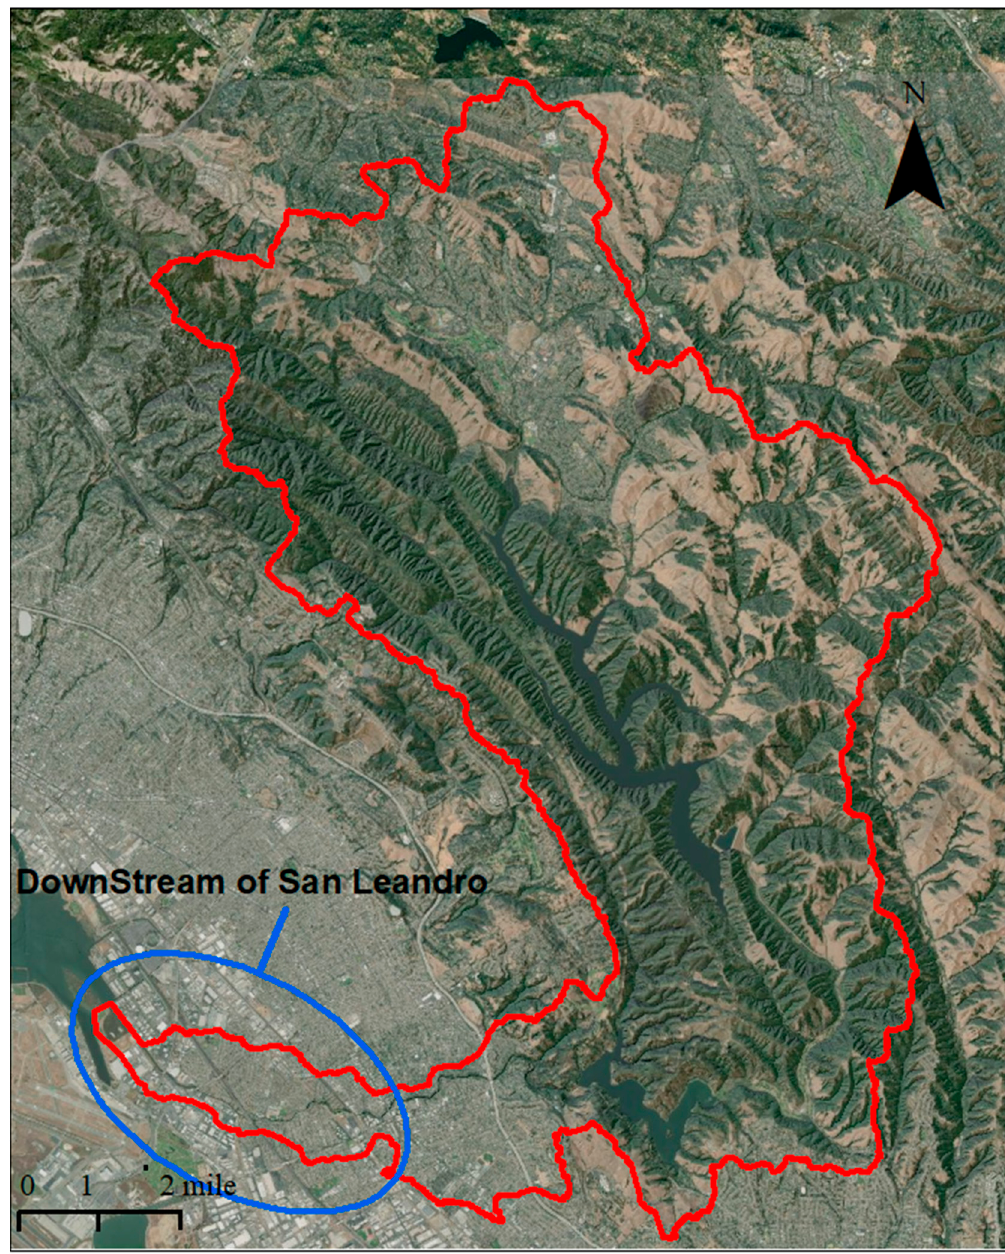
Figure 3. San Leandro watershed. The blue elliptic represents the region that modelled in this study.